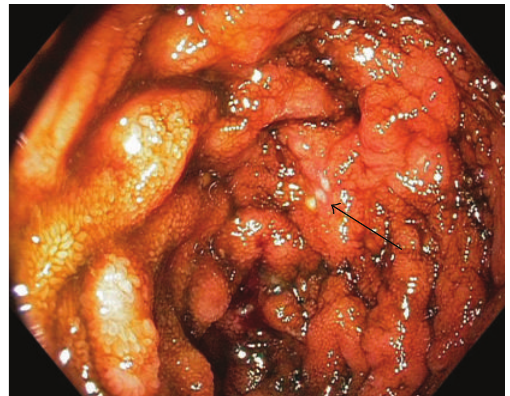
Figure 2: The mucosa of the distal ileum was swollen with friability. A cobblestone appearance with multiple aphtous lesions was seen (arrow).